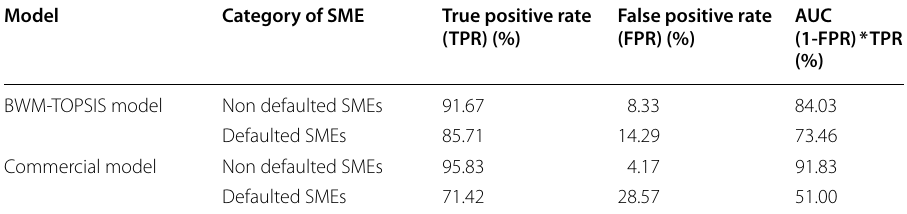
Table 14 Comparisons of AUC results with the commercial model Model